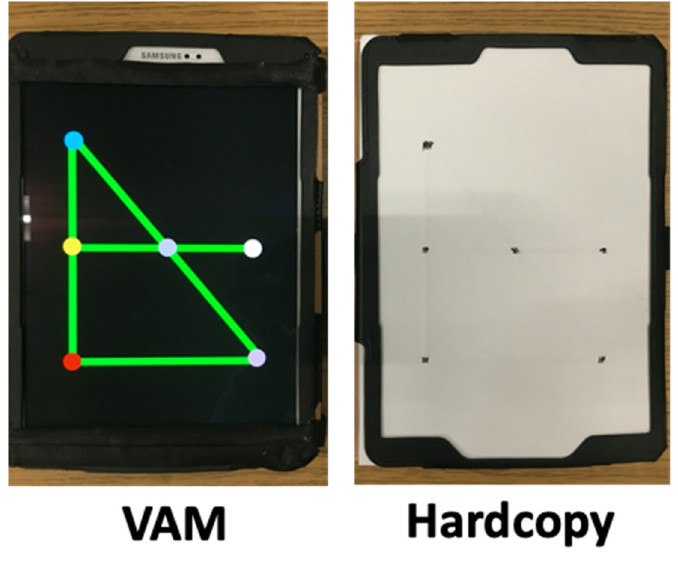
Figure 1. Experimental maps in two learning-mode conditions: vibro-audio map ( left ) and hardcopy tactile map ( right ).